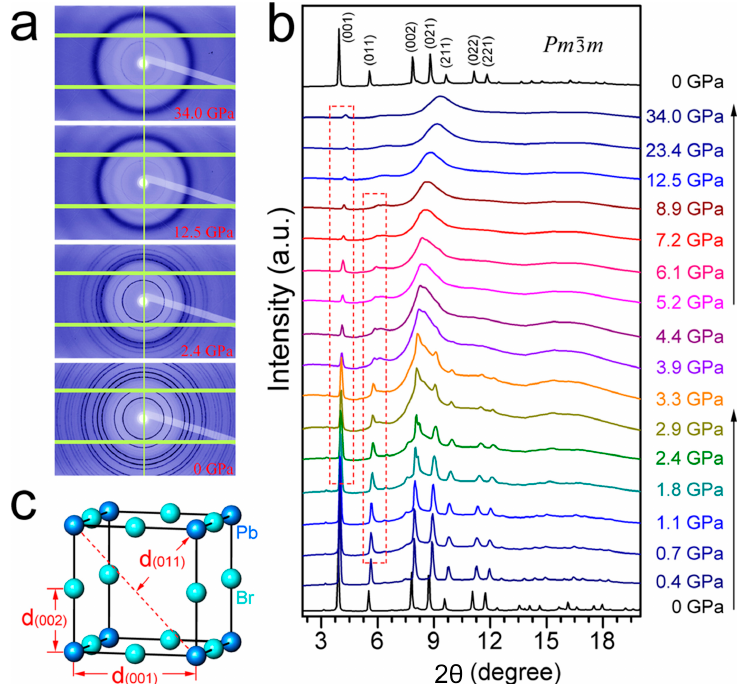
Figure 6. Synchrotron XRD patterns of MAPbBr 3 obtained during compression up to 34.0 GPa